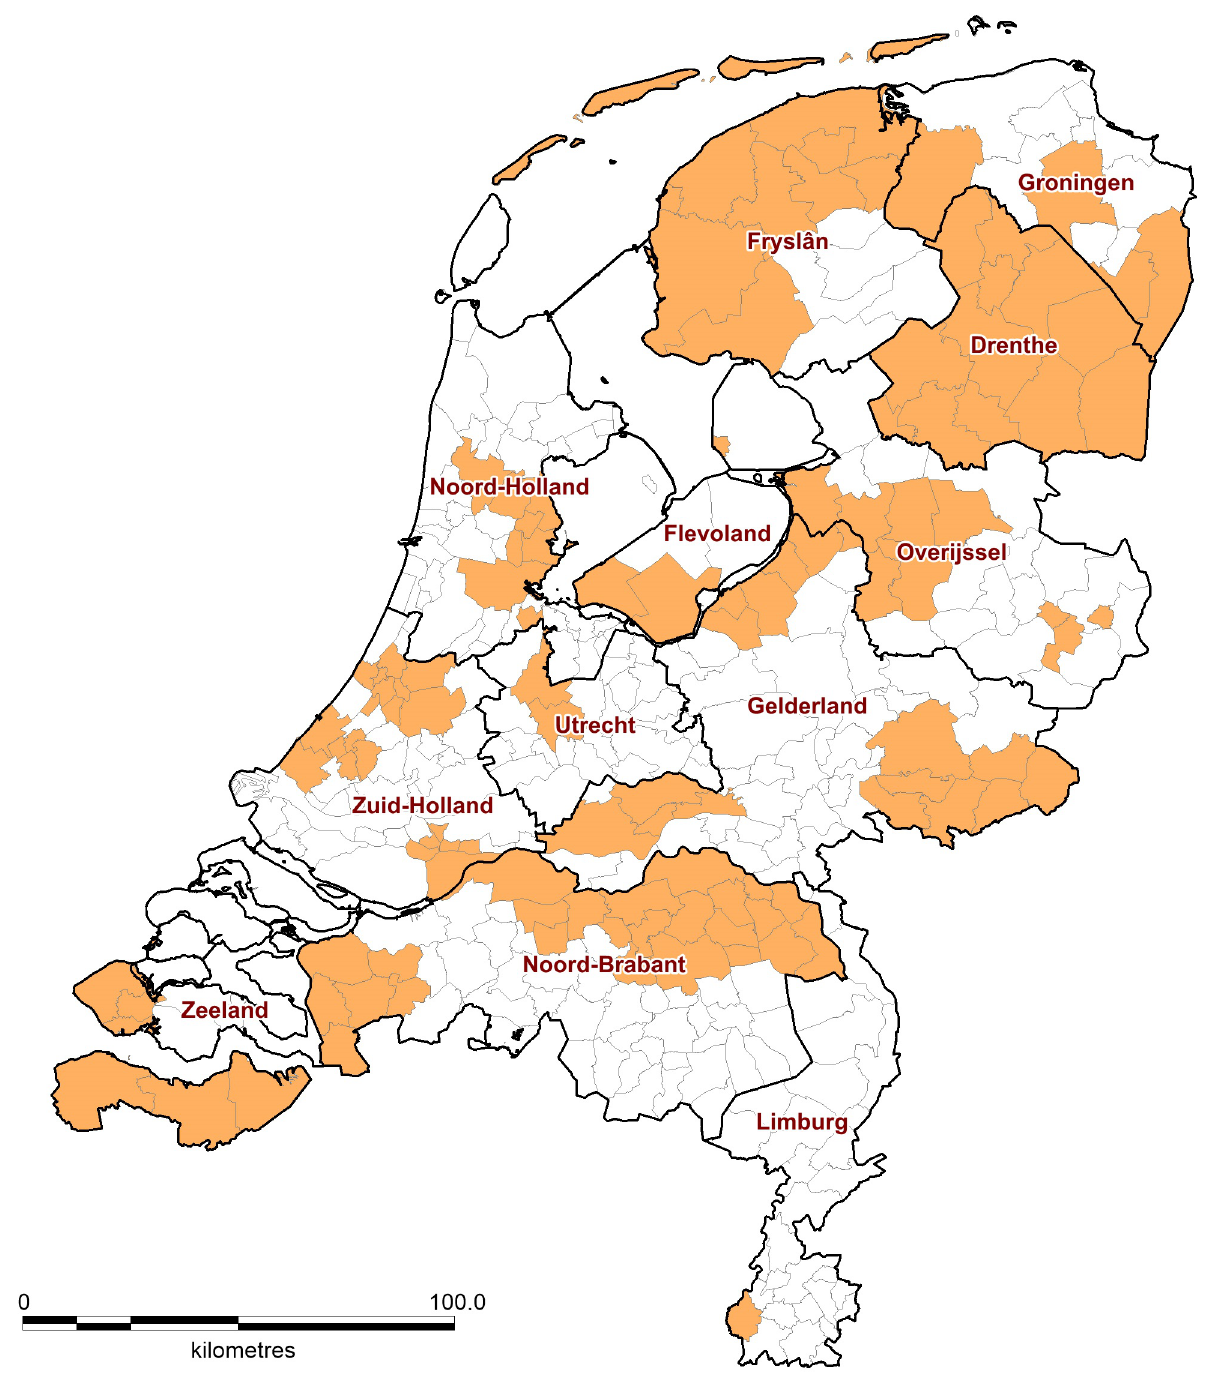
Figure 1. Outline of Dutch municipalities (apricot color) served by the participating animal shelters in this